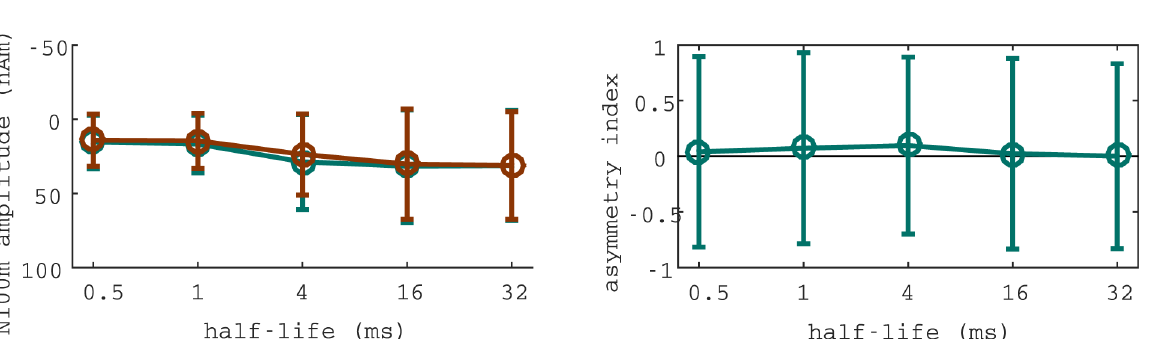
Fig 9. Autocorrelation model ’ s predictions for the amplitude of the N100m peak. Predictions were computed following the same procedure as in the analysis of the top-down modulated model (see Fig 4d). Predictions of the autocorrelation model do not show statistically significant correlations with the N100m values or the perceptual predictions. Moreover, the predicted amplitudes elicited by ramped and damped sinusoids with T 1/2 = 4,ms are not significantly different in this